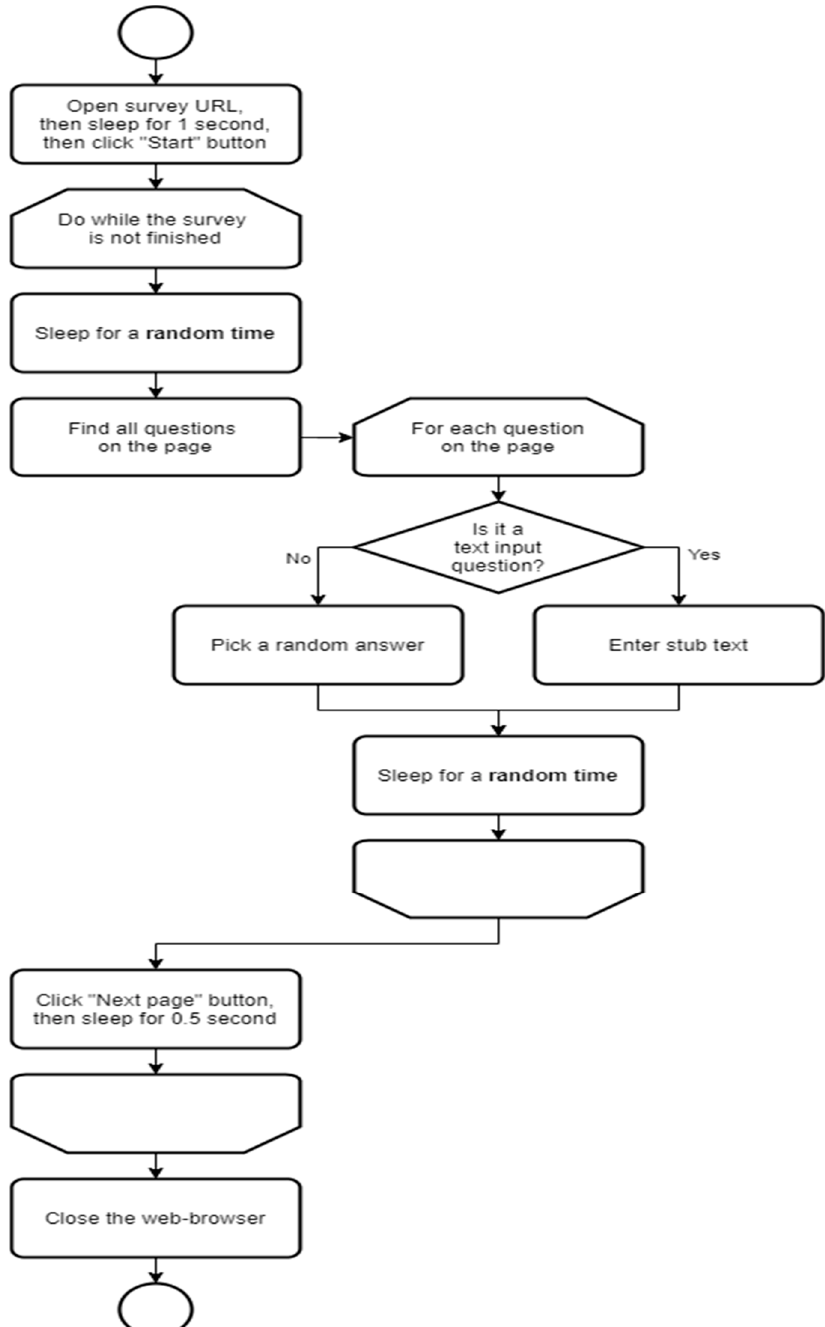
Figure 1. Questionnaire-filling program flowchart.